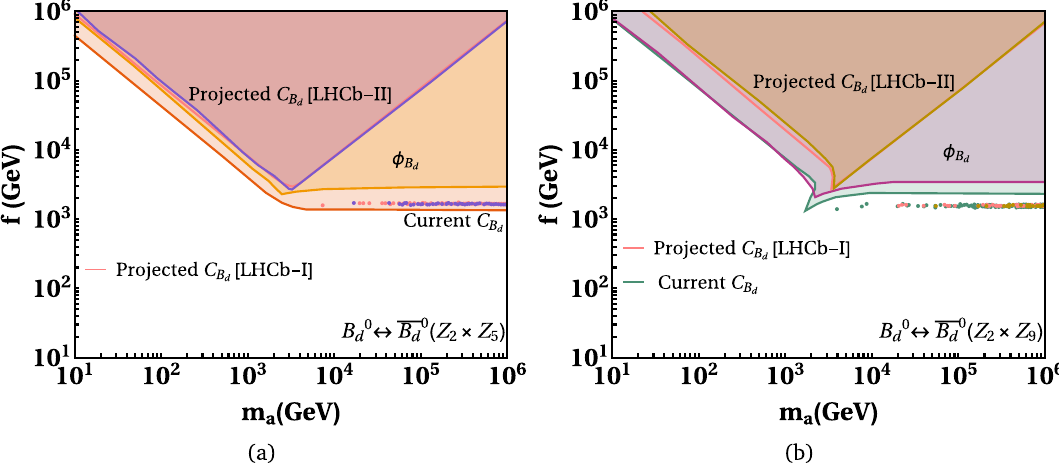
Fig. 4 The allowed parameter space by flavour observables C B left panel and for the non-minimal ( Z 2 × Z 9 ) model in the right